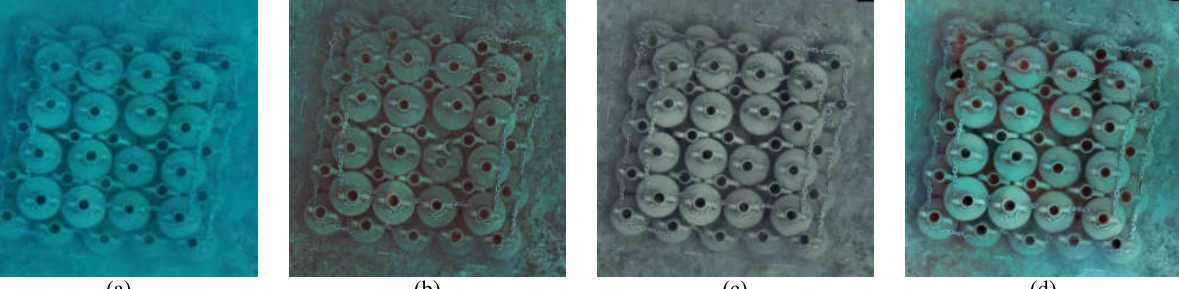
Figure 9. The orthoimage of the deep waters dataset created by using the original images (a), by using the imagery corrected by the CLAHE based algorithm (b), by using the imagery corrected by the algorithm of Bianco et al., (2015) (c), and by using the imagery corrected with Adobe Photoshop (d)